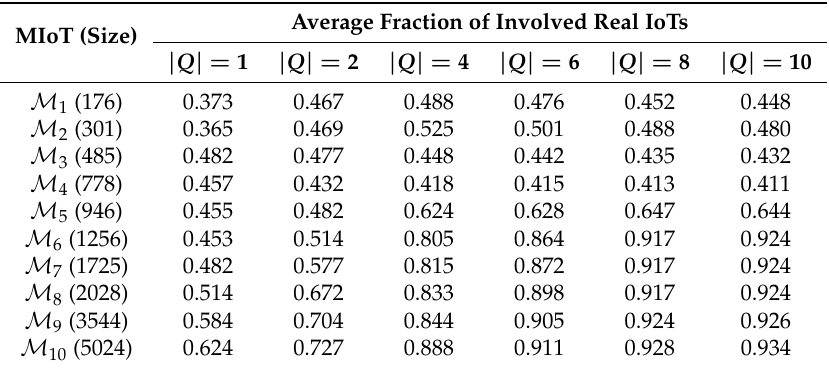
Table 6. Average fraction of real IoTs involved in a virtual IoT against the size of MIoTs and queries used to generate the virtual IoTs (supervised approach).